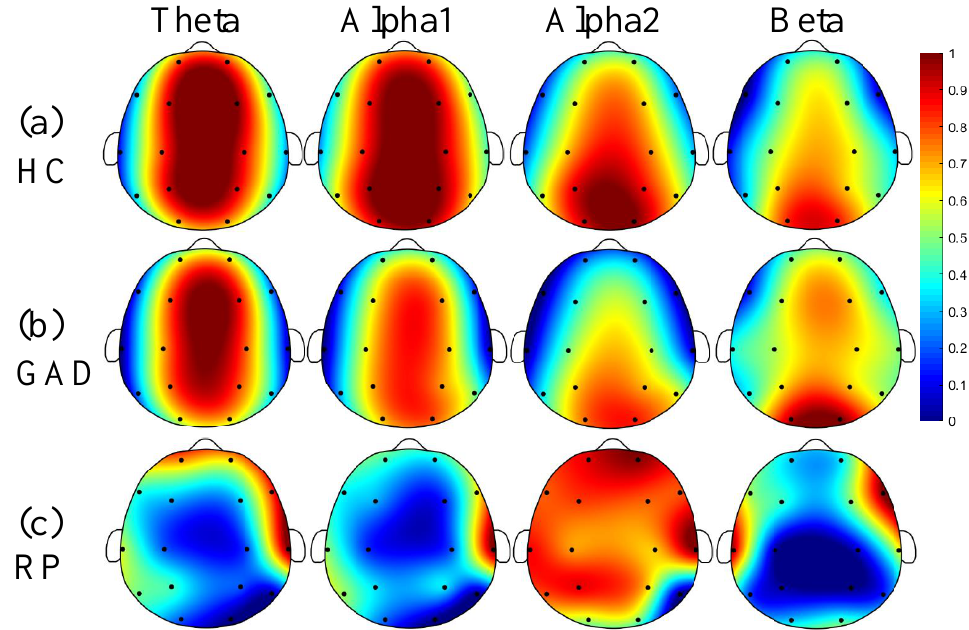
Figure 2. Brain topography of the FE for all EEG rhythms. Each value is the average of all subjects. The FE of HC ( a ) and GAD ( b ) have been normalized between 0 and 1 for the theta, alpha1, alpha2, and beta rhythms for the sake of better visualization, so they share the same color bar. All rhythms have no significant differences ( p > 0.05). The subgraphs of ( c ) are the relative FE (RFE: |FE GAD – FE HC |/FE HC ) of GAD relative to HC for the four rhythms.